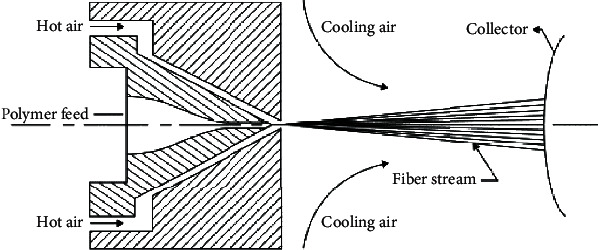
Schematic illustration of air manifold in melt-blown process. Republished with permission from Ref. [61]. Copyright 2014, Woodhead Publishing Limited.